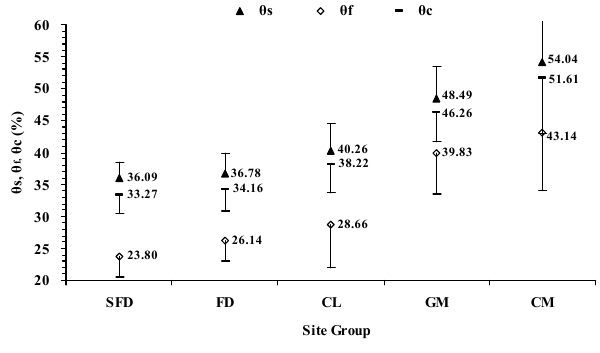
Fig. 9. The saturated soil moisture ( θ s ), field capacity ( θ f ), and capillary rise moisture content ( θ c ) of the study area. Values are means ± standard deviations. SFD stands for semi-fixed dune sites, FD for fixed dune sites, CL for cultivated land sites, GM for general meadow sites, and CM for control meadow sites where there was no detectable erosion and sand accumulation.